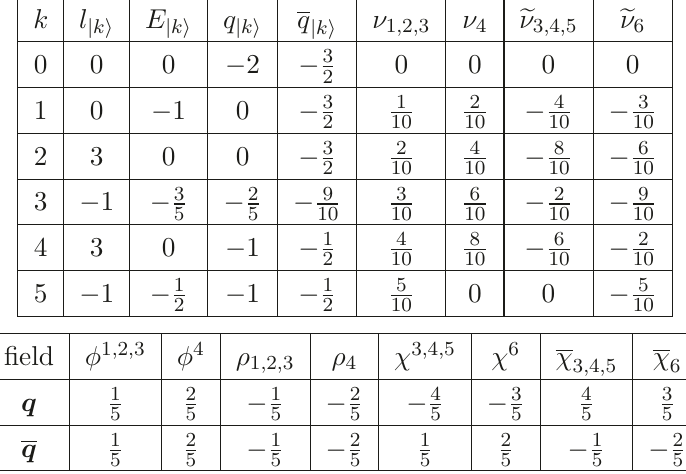
Table 4 . Quantum numbers for the SO(10)